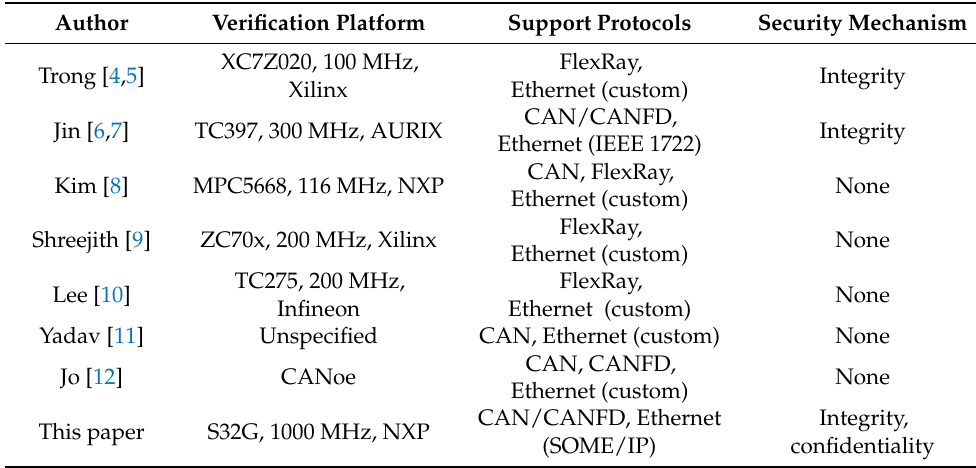
Table 1. The contributions of this work compared to the state of the